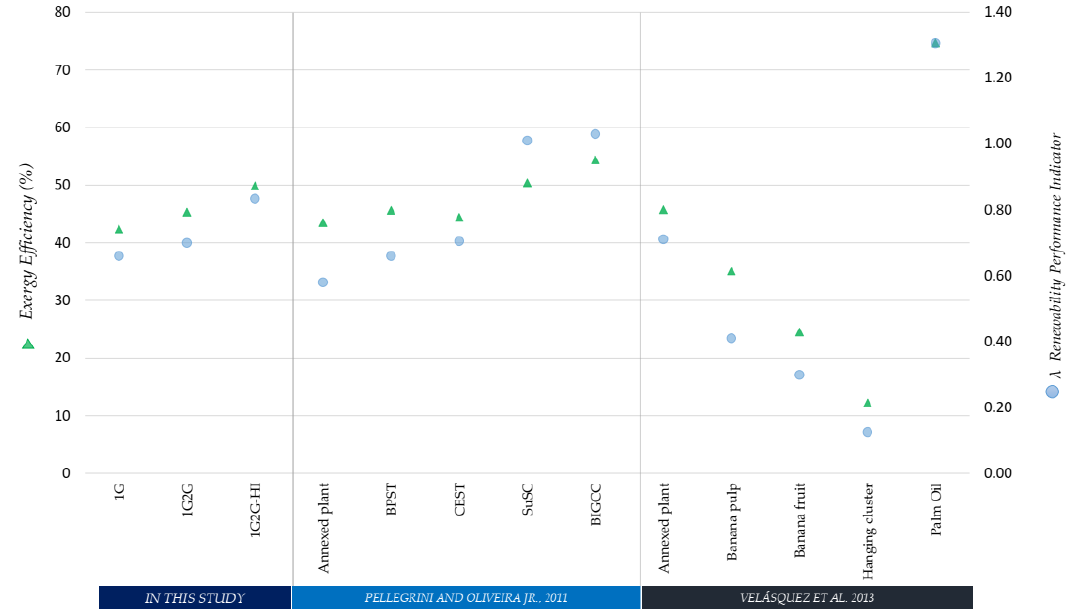
Figure 4. Relation between the exergy e ffi ciency and the renewability performance